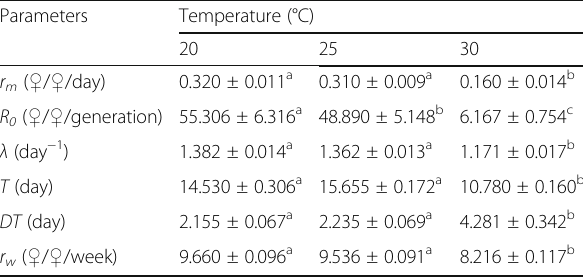
Table 3 Life table parameters (mean ± SE) of Aphidius matricariae parasitizing Schizaphis graminum at various temperatures